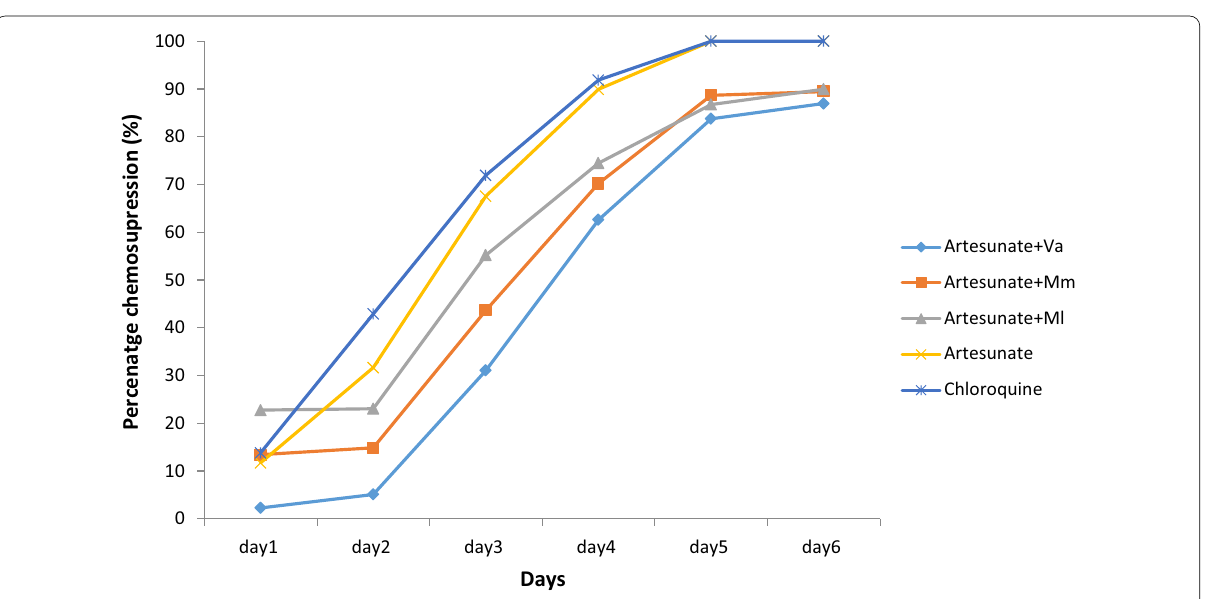
Values were expressed as mean standard deviation (SD). Values with different superscripts (Alphabets) in a column are significantly different ( p < 0.05) from each ± other. This implies that for each day, values with superscript (a) are the least value, followed by b then c, d e to f (highest). For example, at day 1, the lowest values for percentage parasitaemia were recorded in mice treated with artesunate Ml followed by that of chloroquine while the highest parasitaemia was in untreated mice. + These differences are statistically significant (all the values did not have similar superscript). At days 5 and 6, mice treated with artesunate and chloroquine have the least values for parasitaemia and both the same superscripts (a). This means they are not significantly different from one another. The opposite goes for mice treated with (artesunate Mm) and (artesunate Ml) at day 6. The former was significantly higher than the latter ( p < 0.05) due to the fact that the two values share different + + superscripts (b and c) Mean values were from five mice observed in each group